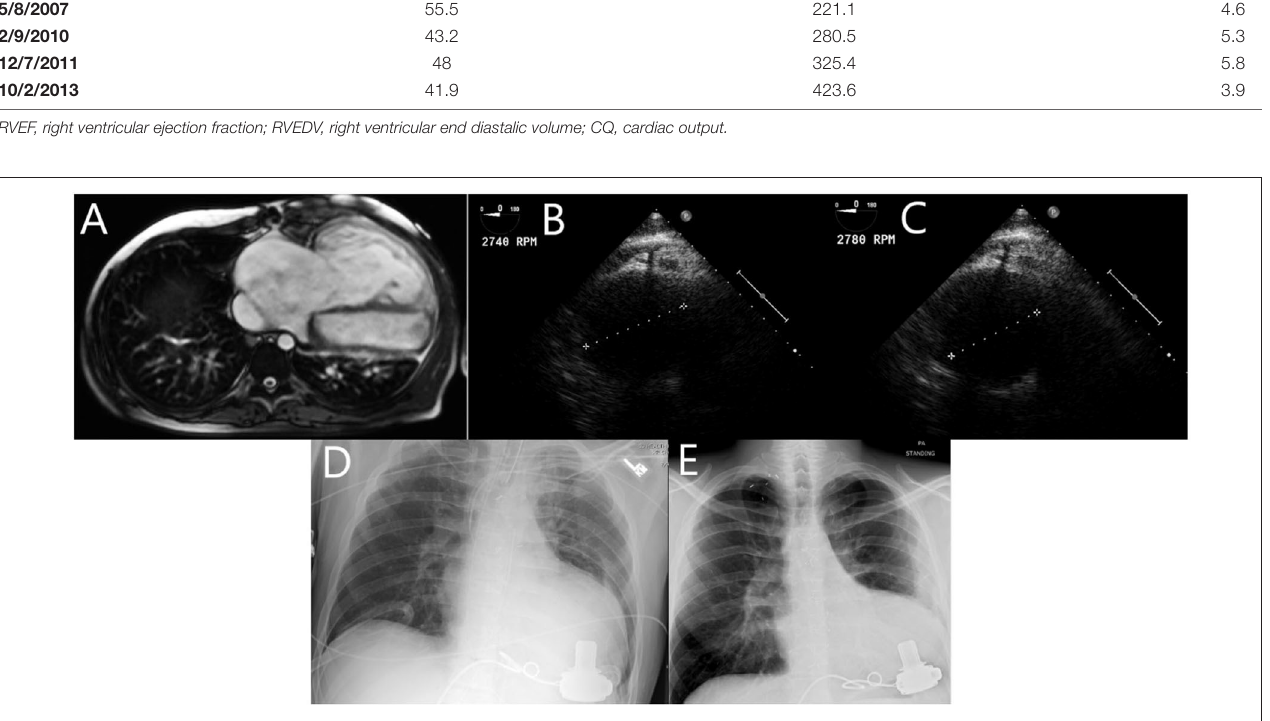
FIGURE 1 | (A) : Cardiac MRI showing severely dilated and hypertrophied RV with mildly diminished systolic function. (B, C) : TEE monitoring showing RV chamber size decrease from 6.2cm at low VAD speed (2,740 RPM) to 5.3cm at high VAD speed (2,780 RPM) (D, E) : Chest x-ray showing significant decrease in RV size between post-operative day 1 and 10 months